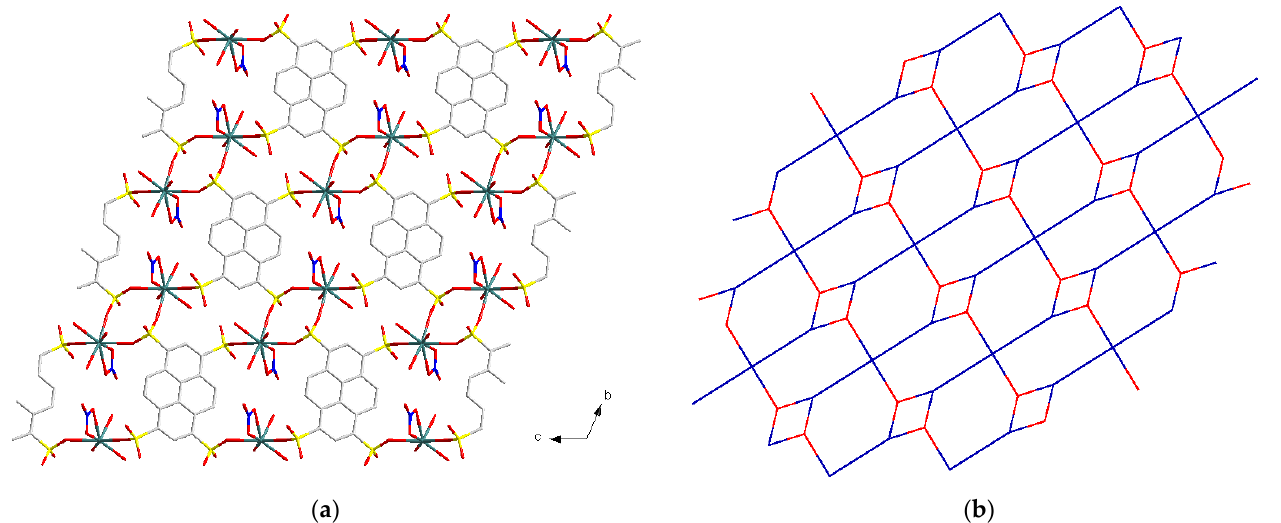
Figure 5. ( a ) Two-dimensional layered structure and ( b ) corresponding topological diagram in compound 2 . compound 2 .